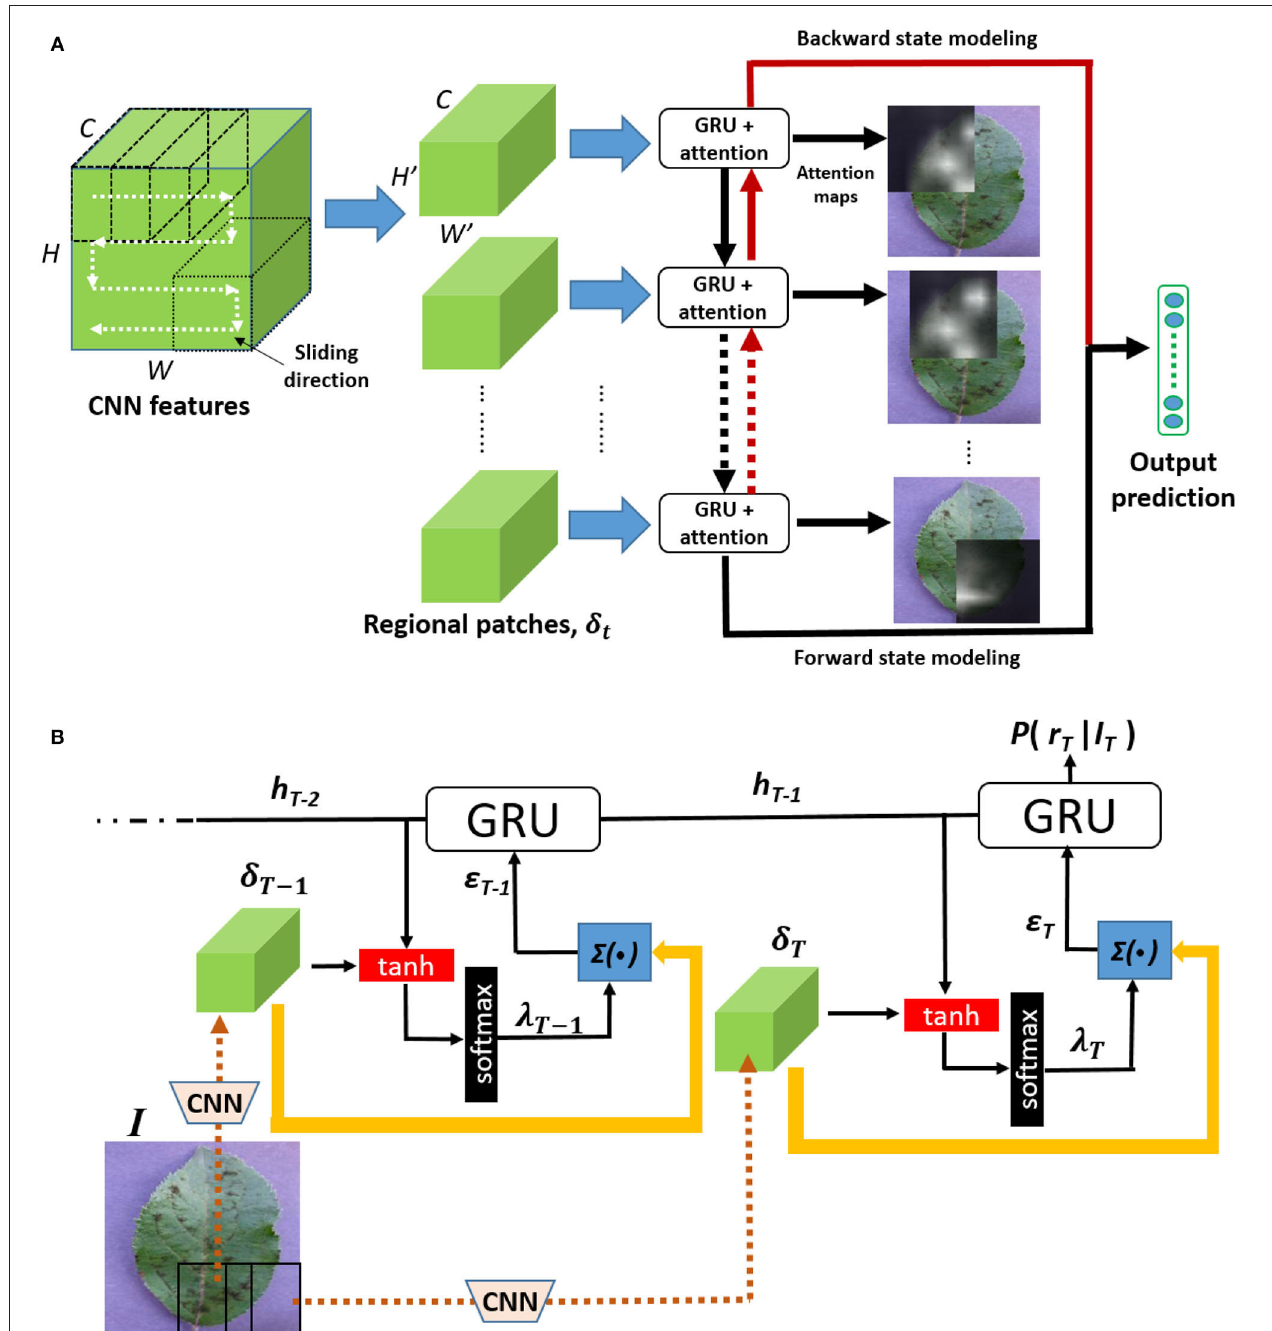
FIGURE 2 | The proposed architecture: from an image of a contaminated plant, feature maps are first extracted from a given convolutional layer of a pre-trained CNN. They are then sliced into several patches following a “snaking” sliding direction. The patches then feed into Gated Recurrent Units that share, combine, and retain relevant information in a bidirectional way to update an internal representation of plant disease. Soft attention mechanism is used to infer discriminating local features. (A) Overall architecture. (B) Soft attention mechanism.